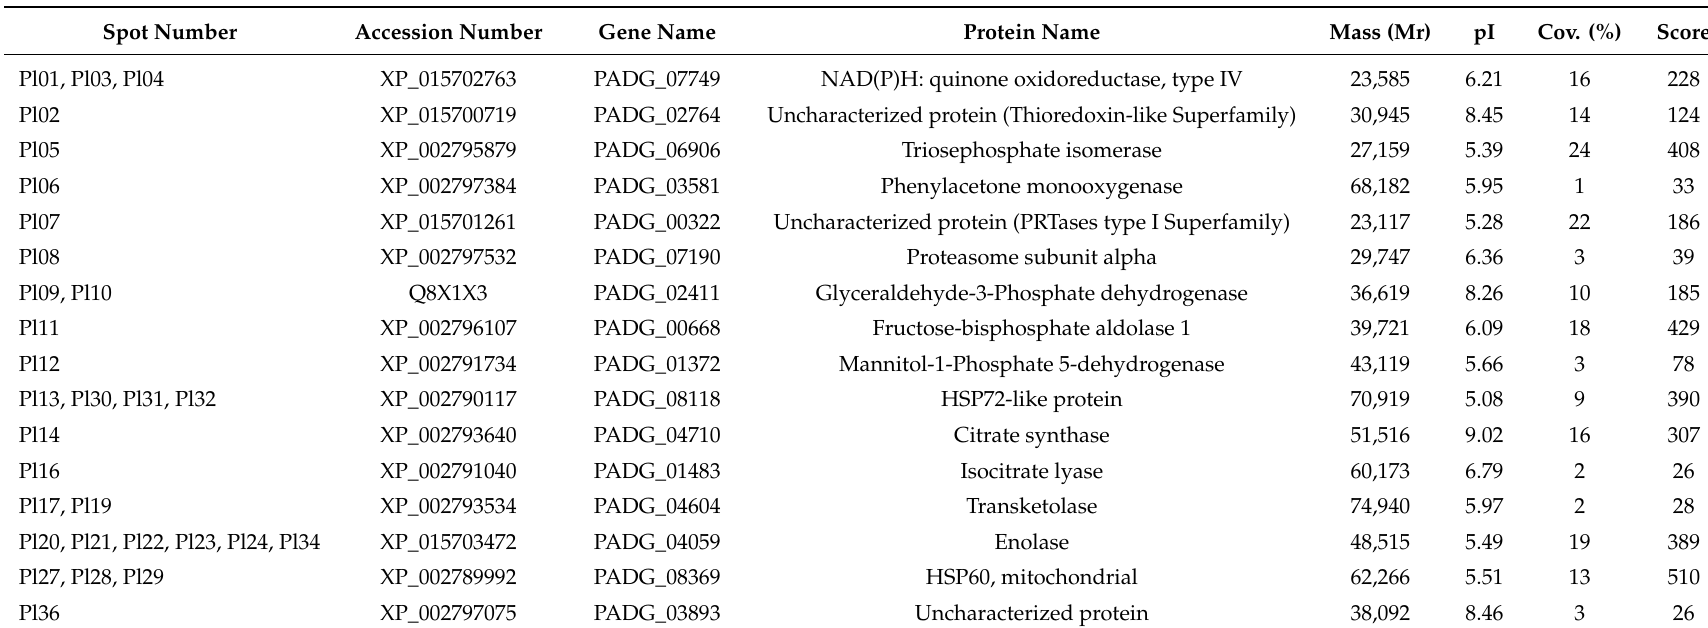
Table 1. Identification of IgG-reactive proteins recognized by sera of patients with paracoccidioidomycosis due to Paracoccidioides lutzii